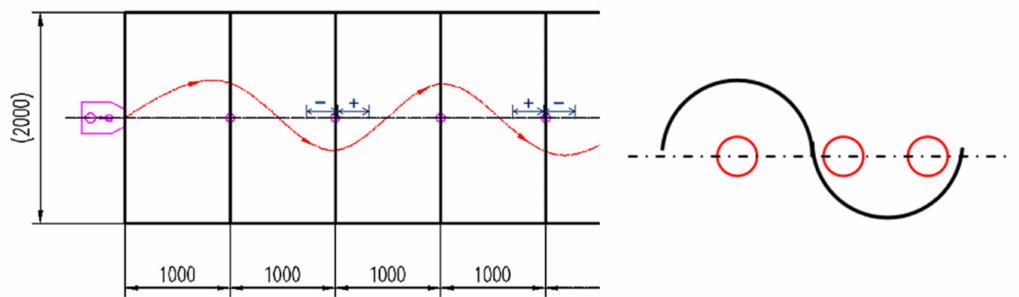
Figure 3. Obstacle positions.